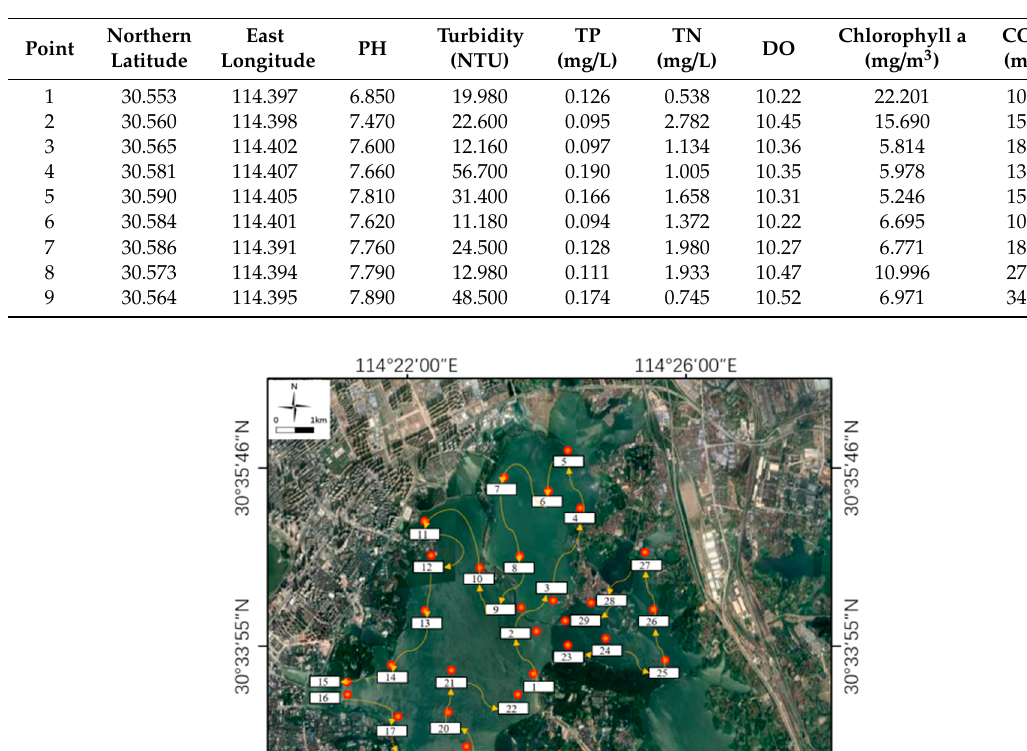
Table 1. Measured water quality data of Donghu Lake ( 2017.12 ) .